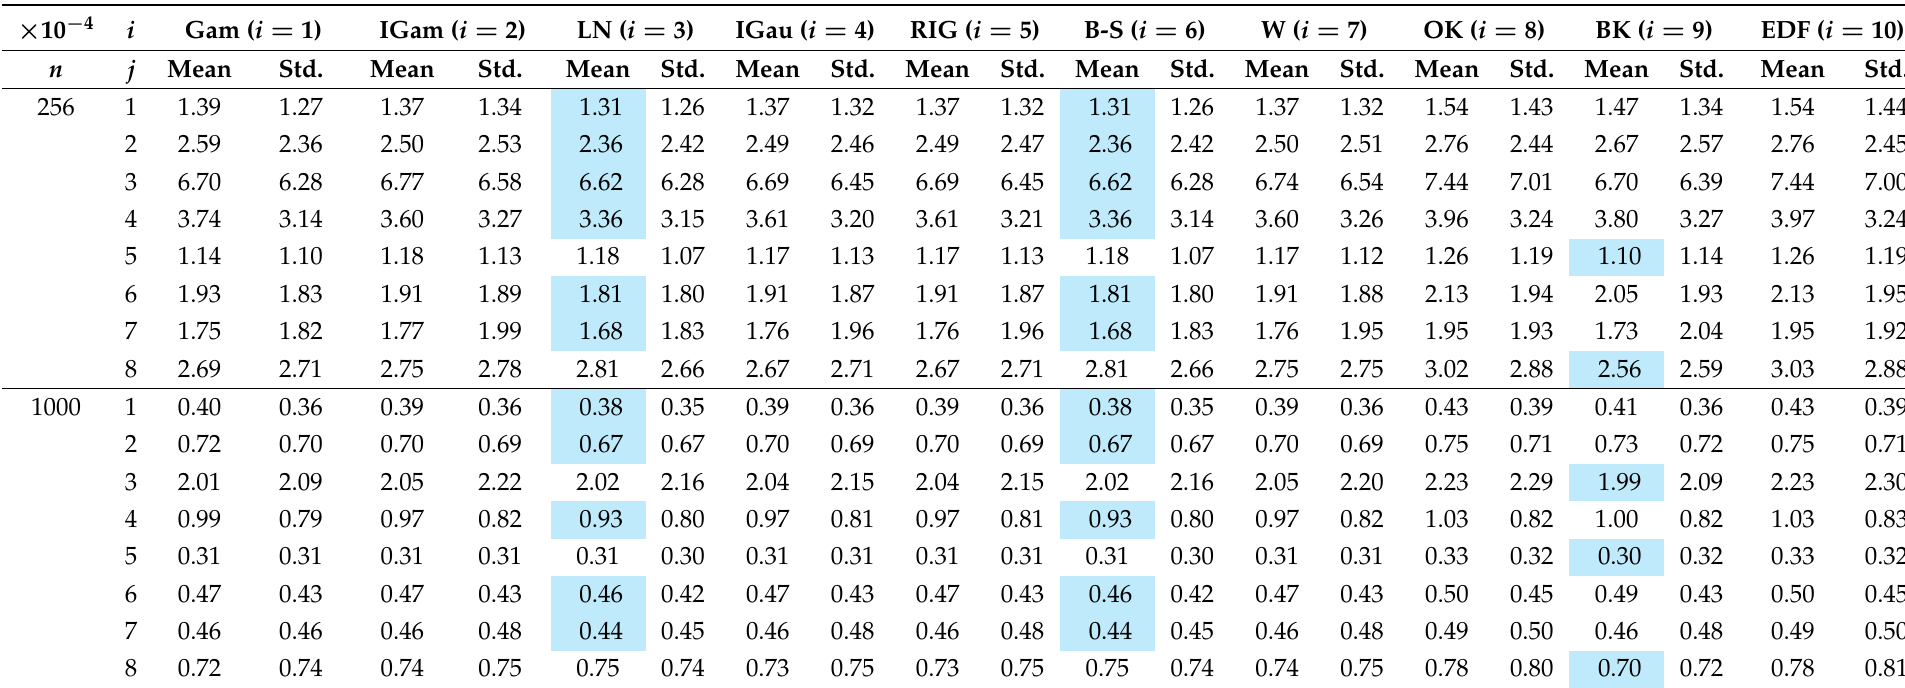
( k ) Table 1. The mean and standard deviation of the ISE , k = 1,2, . . . , M , for the eight target distributions ( i = 1,2, . . . ,8), the ten estimators ( j = 1,2, . . . ,10) and the two sample sizes i , j , n ( n = 256,1000). All the values presented in the table have been multiplied by 10 4 . The ordinary kernel estimator ˆ F 8 is denoted by OK, the boundary kernel estimator ˆ F 9 is denoted by BK, and the empirical c.d.f. ˆ F 10 is denoted by EDF. For each line in the table, the lowest ISE means are highlighted in